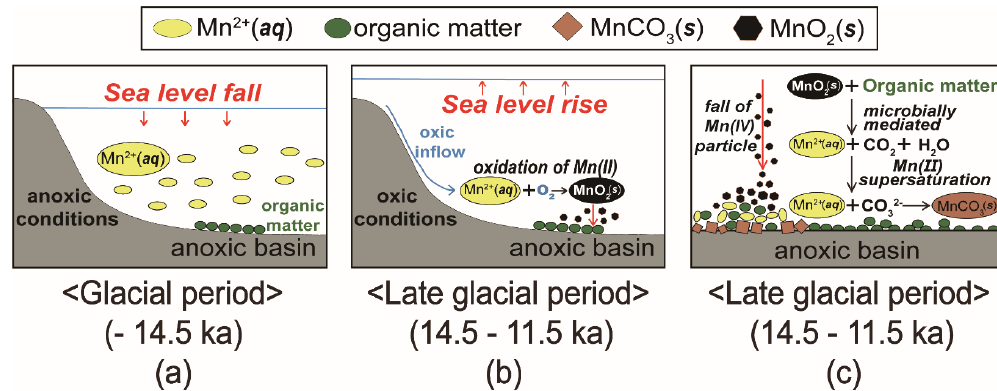
Figure 10. Formation of Microbially Induced Mn-Carbonates. The black arrow is a chemical reaction, while the red arrows show sea level changes. ( a ) represents anoxic conditions during the glacial period with a sea level fall. ( b ) represents the late glacial period with a sea level rise, and thus oxic water circulation. ( c ) is the redox reaction of Mn, and consequently the occurrence of Mn-carbonates, at the anoxic basin floor.